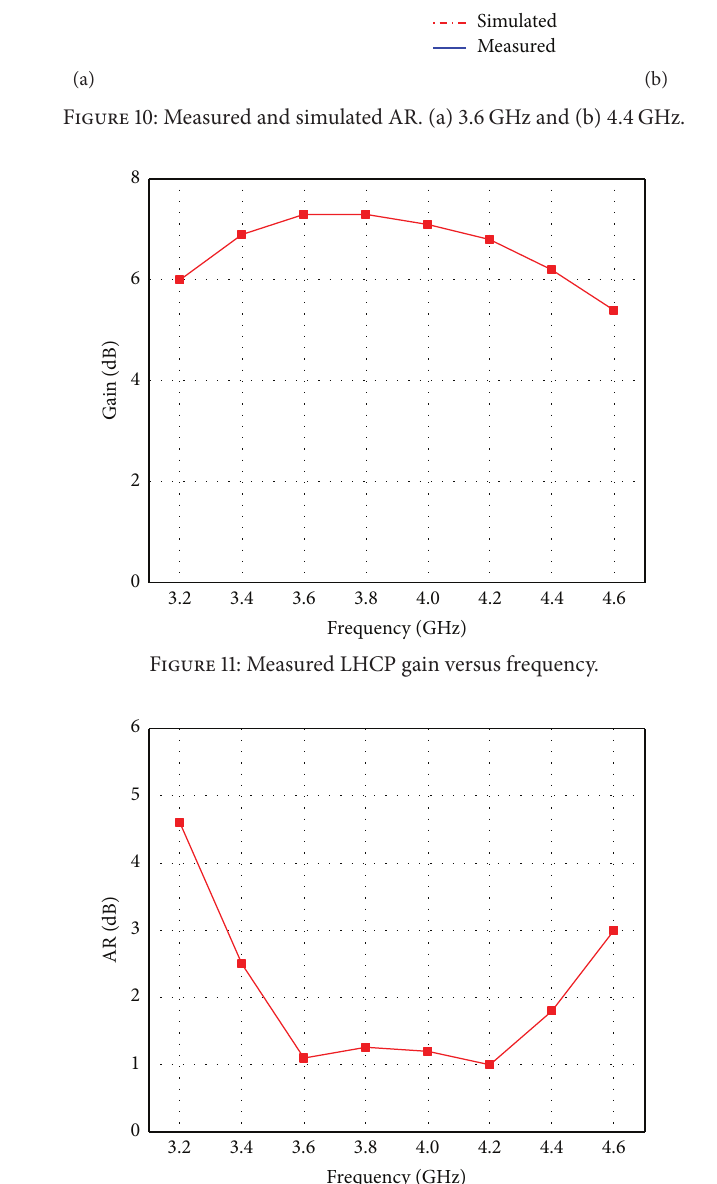
Figure 12: Measured AR versus